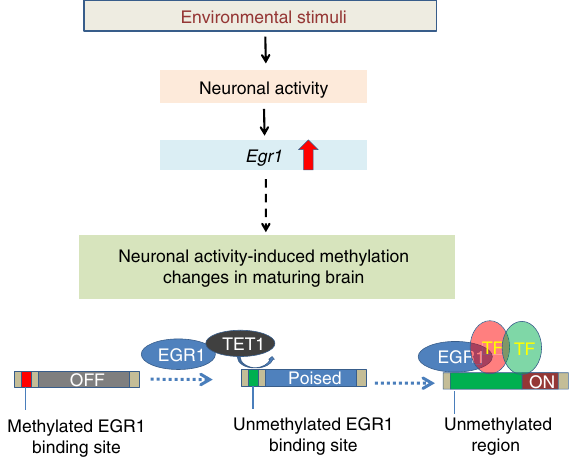
Fig. 6 A simpli fi ed model for EGR1 and TET1 interaction linking environmental stimuli to brain methylome programming. At birth, Egr1 - mediated and neuronal activity-induced genes are silenced with methylated EGR1 binding sites. During postnatal development and upon neuronal activity, the increase in expression of Tet1 and Egr1 leads to the demethylation of EGR1 binding sites to facilitate the binding of co-factors and shifts the genes to either “ Poised ” or “ ON ” states. DNA methylation cannot block EGR1 binding but may prevent the bindings of other transcription factors, which bind to the regions adjacent to EGR1 binding sites. Thus, the demethylation of EGR1 binding sites may facilitate the formation of stronger transcription